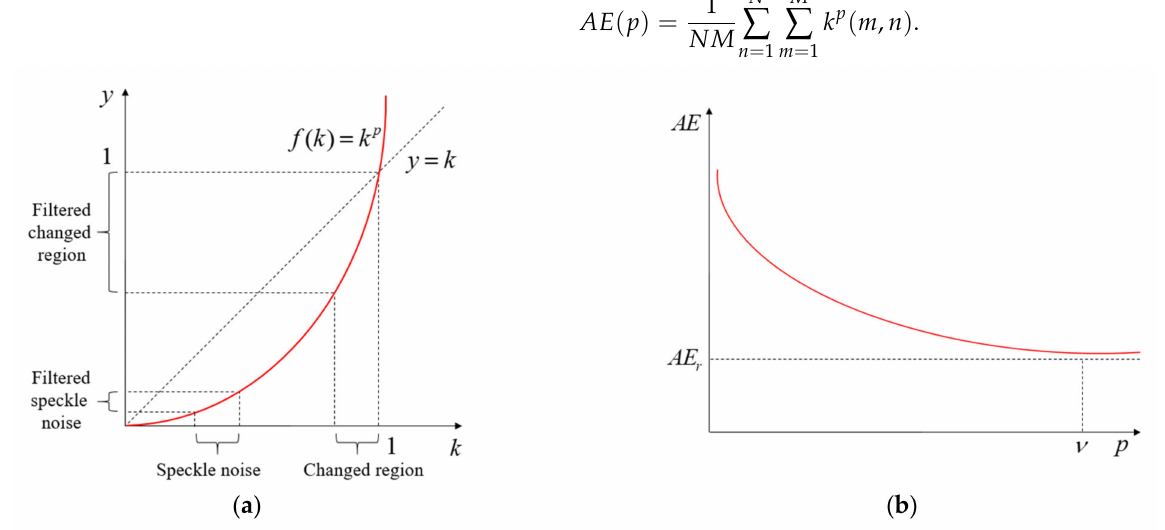
Figure 2. ( a ) Illustration of the GC filtering, ( b ) AE versus value of p